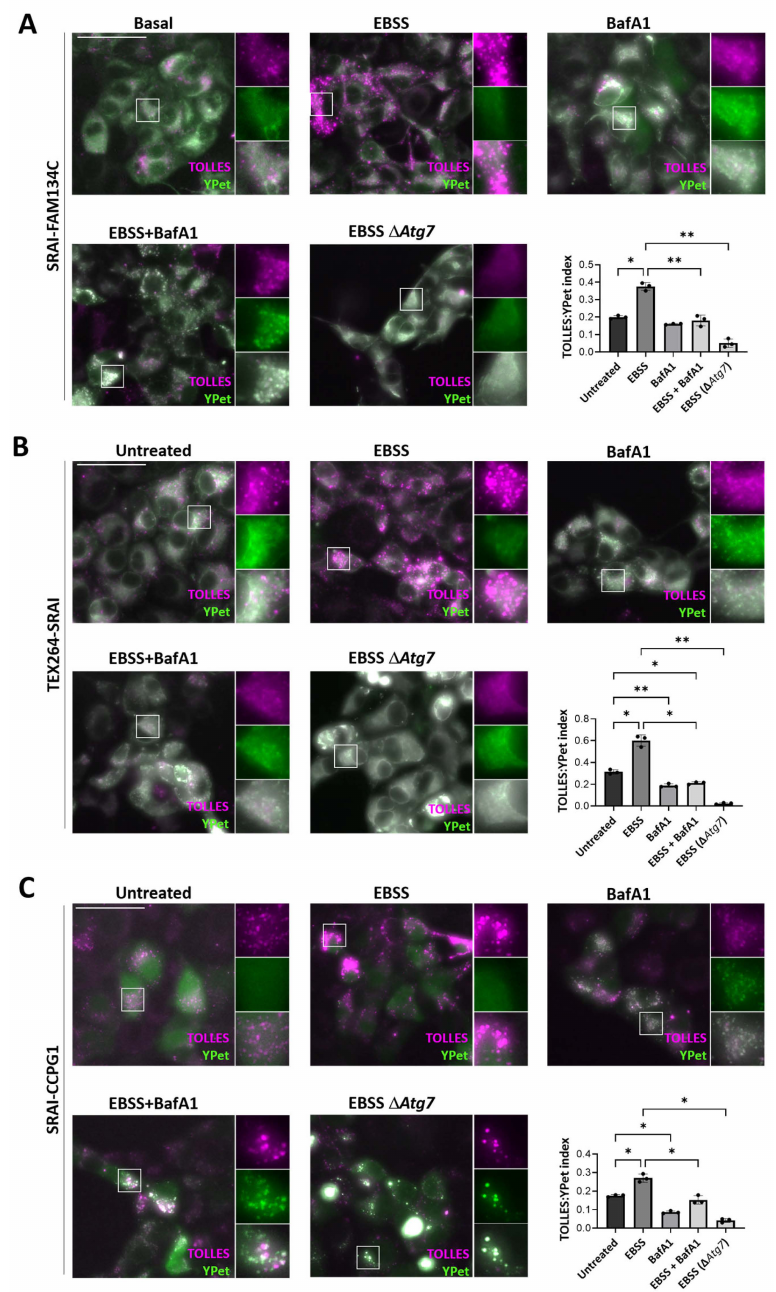
Figure 5. ER-phagy flux driven by specific ER-phagy receptors can be detected using the SRAI probe. ( A – C ) Imaging-based autophagic flux assay in PDAC cells stably expressing SRAI-FAM134C ( A ) or TEX264-SRAI ( B ) or SRAI-CCPG1 ( C ) (transfected with sgControl or sgAtg7 ) in full nutrients (untreated) or following 4 h starvation in the presence or absence of BafA1 (50 nM) and imaged using automated widefield microscopy. Representative immunofluorescence images of TOLLES (magenta) and YPet (green). Bar = 50 µ m. On the bottom right, quantification of the TOLLES:YPet index ( n =